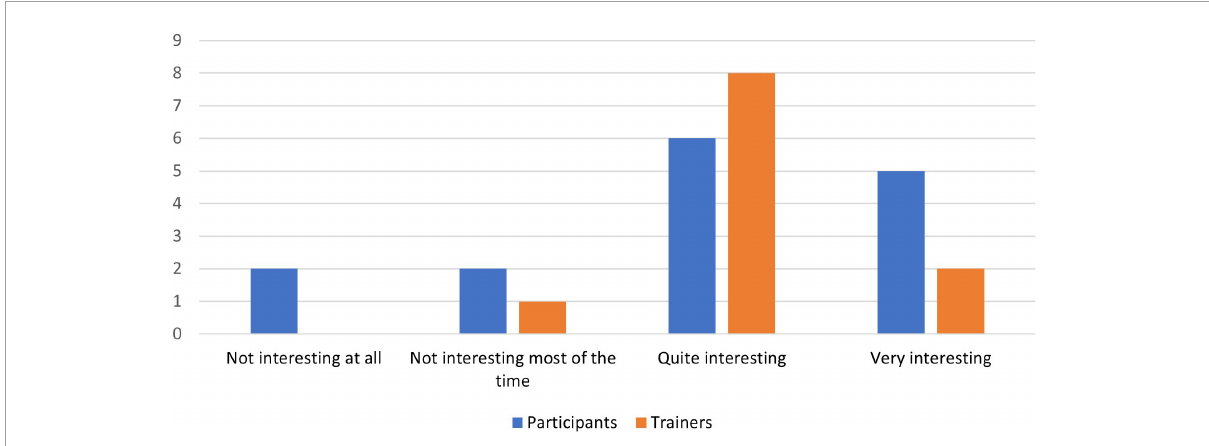
FIGURE6 Feedback on the interest level of the Augmented Reality Games to Enhance Vocational Ability of Patients (REAP) program.